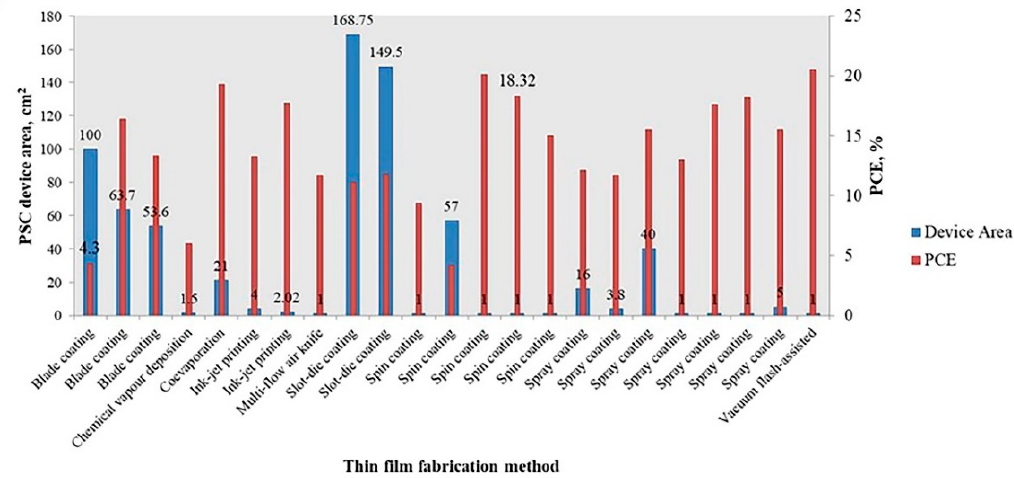
Figure 18. Comparison of published successful large-area PSCs deposition methods, PCE values, and device areas (all ≥ 1 cm 2 ) discussed in this current work.